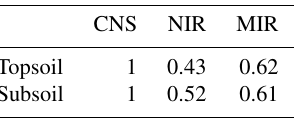
Table 2. Weights given to the